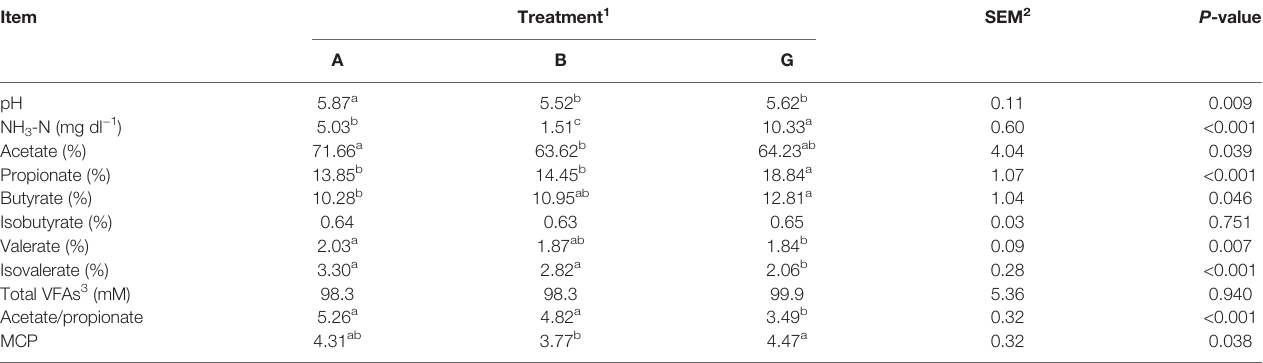
TABLE 4 | Rumen fermentation parameters affected by dietary different non-protein nitrogen sources. Item